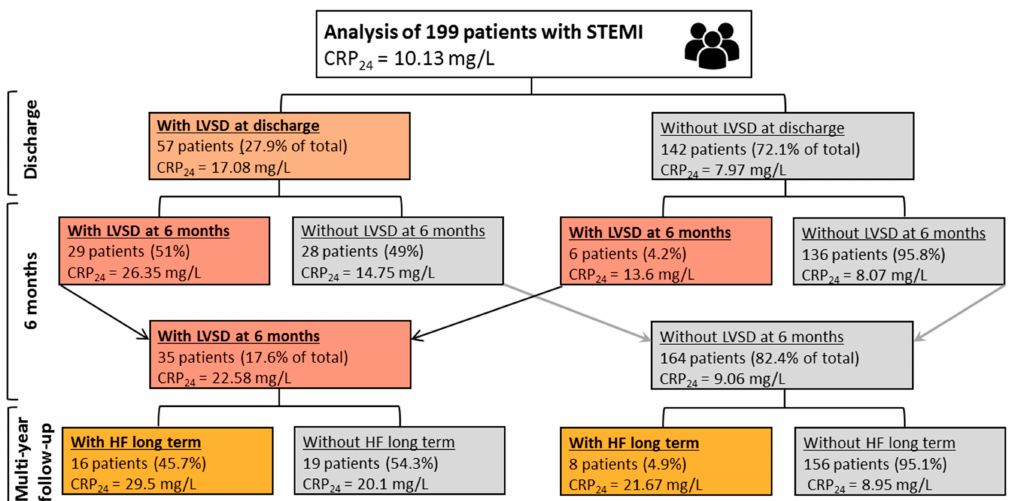
Figure 1. Occurrence of left ventricular systolic dysfunction (LVSD) at discharge and 6 months after discharge, and hospitalization for heart failure (HF) in long-term follow-up, with corresponding median concentration of C-reactive protein 24h after admission (CRP 24 ) for ST-segment elevation myocardial infarction